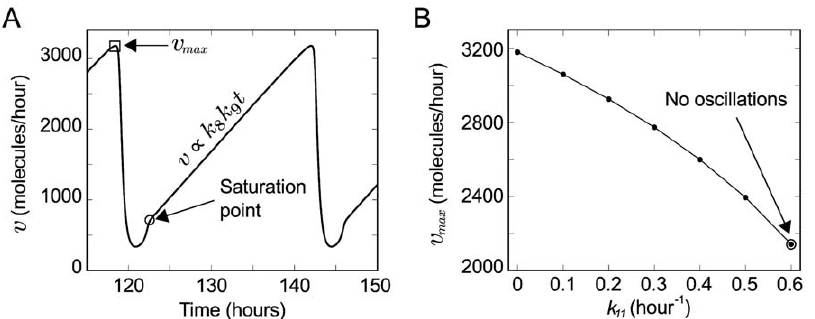
Figure 6. Rate of the negative interaction. A. Rate of the negative interaction ( u ~ k 8 C ). This rate represents the number of degraded A molecules per hour. The graph was plotted by multiplying the number of C molecules in Fig. 3F by k 8 . The circle ( 0 ) indicates the saturation point. At the saturation point the rate increases linearly ( u ! k 8 k 9 t ) because new R molecules enter the system at rate k 9 . The square ( h ) indicates the maximum rate of the negative interaction ( u max ~ 3,180 molecules/hour). B. Plot of u max against k 11 , where k 11 is the rate of the reaction: C w . Each point corresponds to a deterministic simulation with k 11 equal to 0.0, 0.1, 0.2, 0.3, 0.4, 0.5 and 0.6 hour { 1 , respectively (see Fig. S5 for more detailed information). The oscillations stop when k 11 ~ 0.6 hour { 1 ( 0 ) (Fig. S5G).